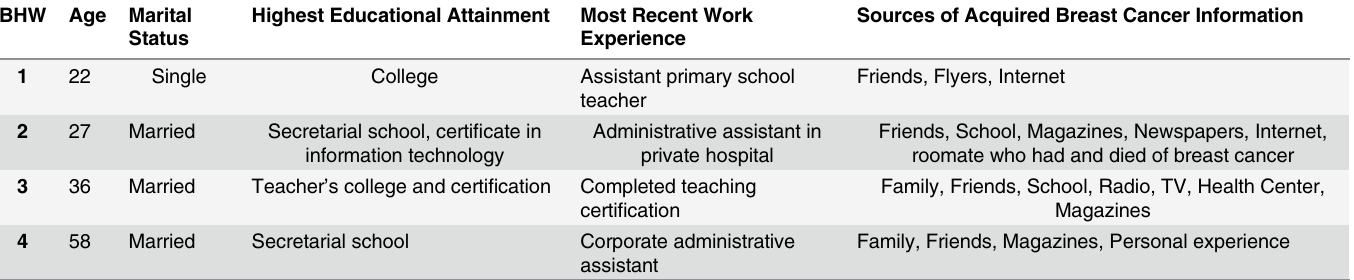
Table 1. Characteristics of Breast Health Workers.